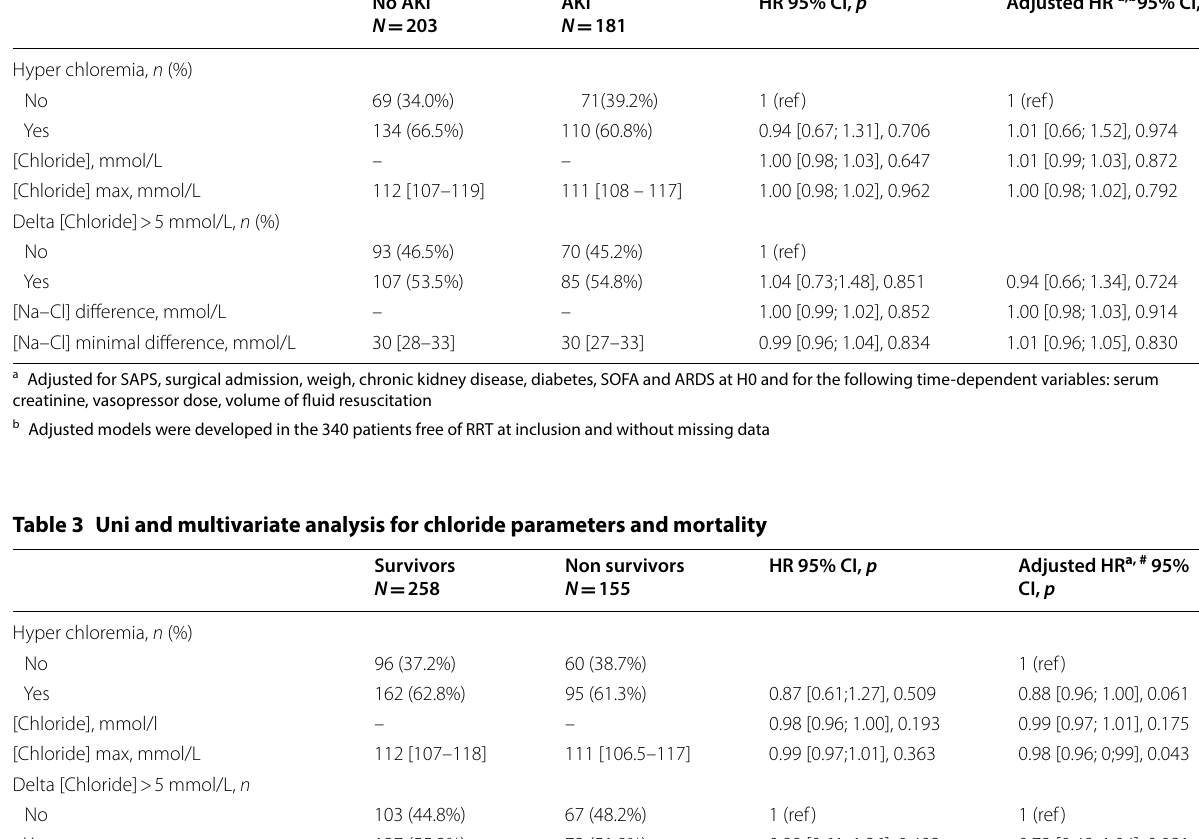
Table 2 Uni and multivariate analysis for chloride parameters and AKI